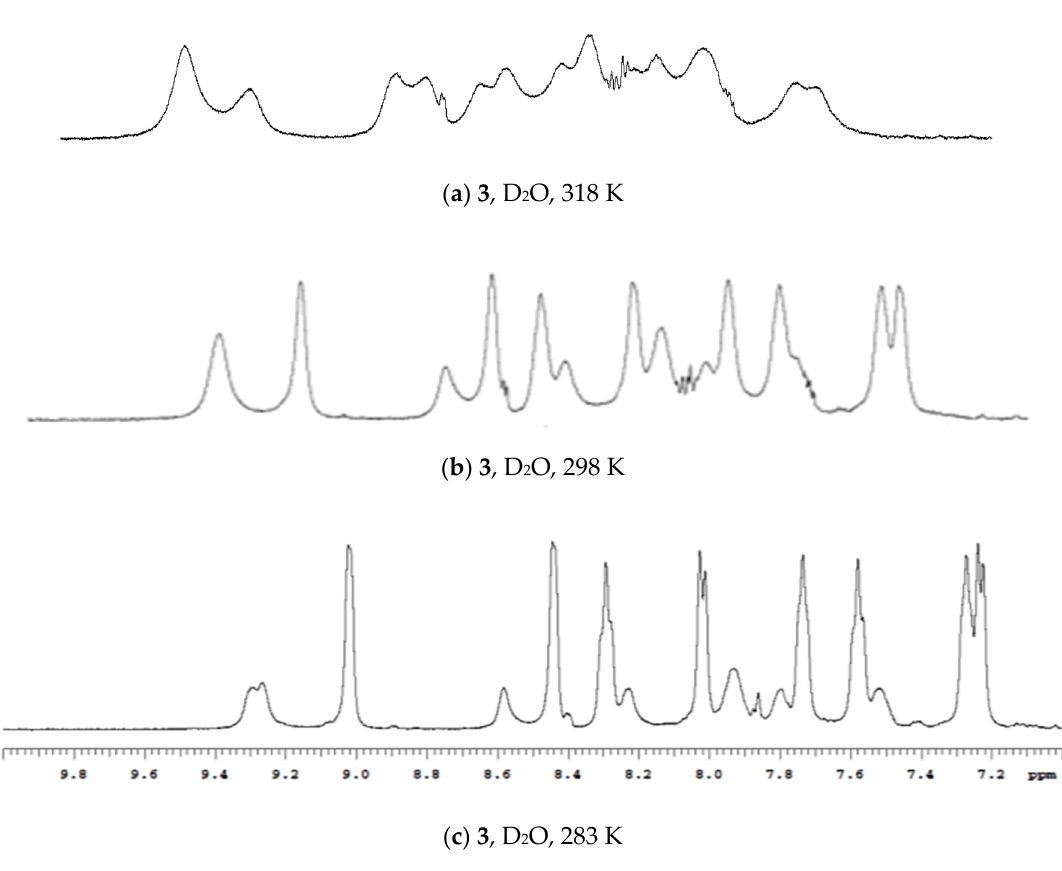
Figure 8. 500 MHz 1 H NMR spectrum of a solution containing 5 mg of 3 dissolved in 0.5 mL of D 2 O (99.8%), showing temperature dependence of the complex